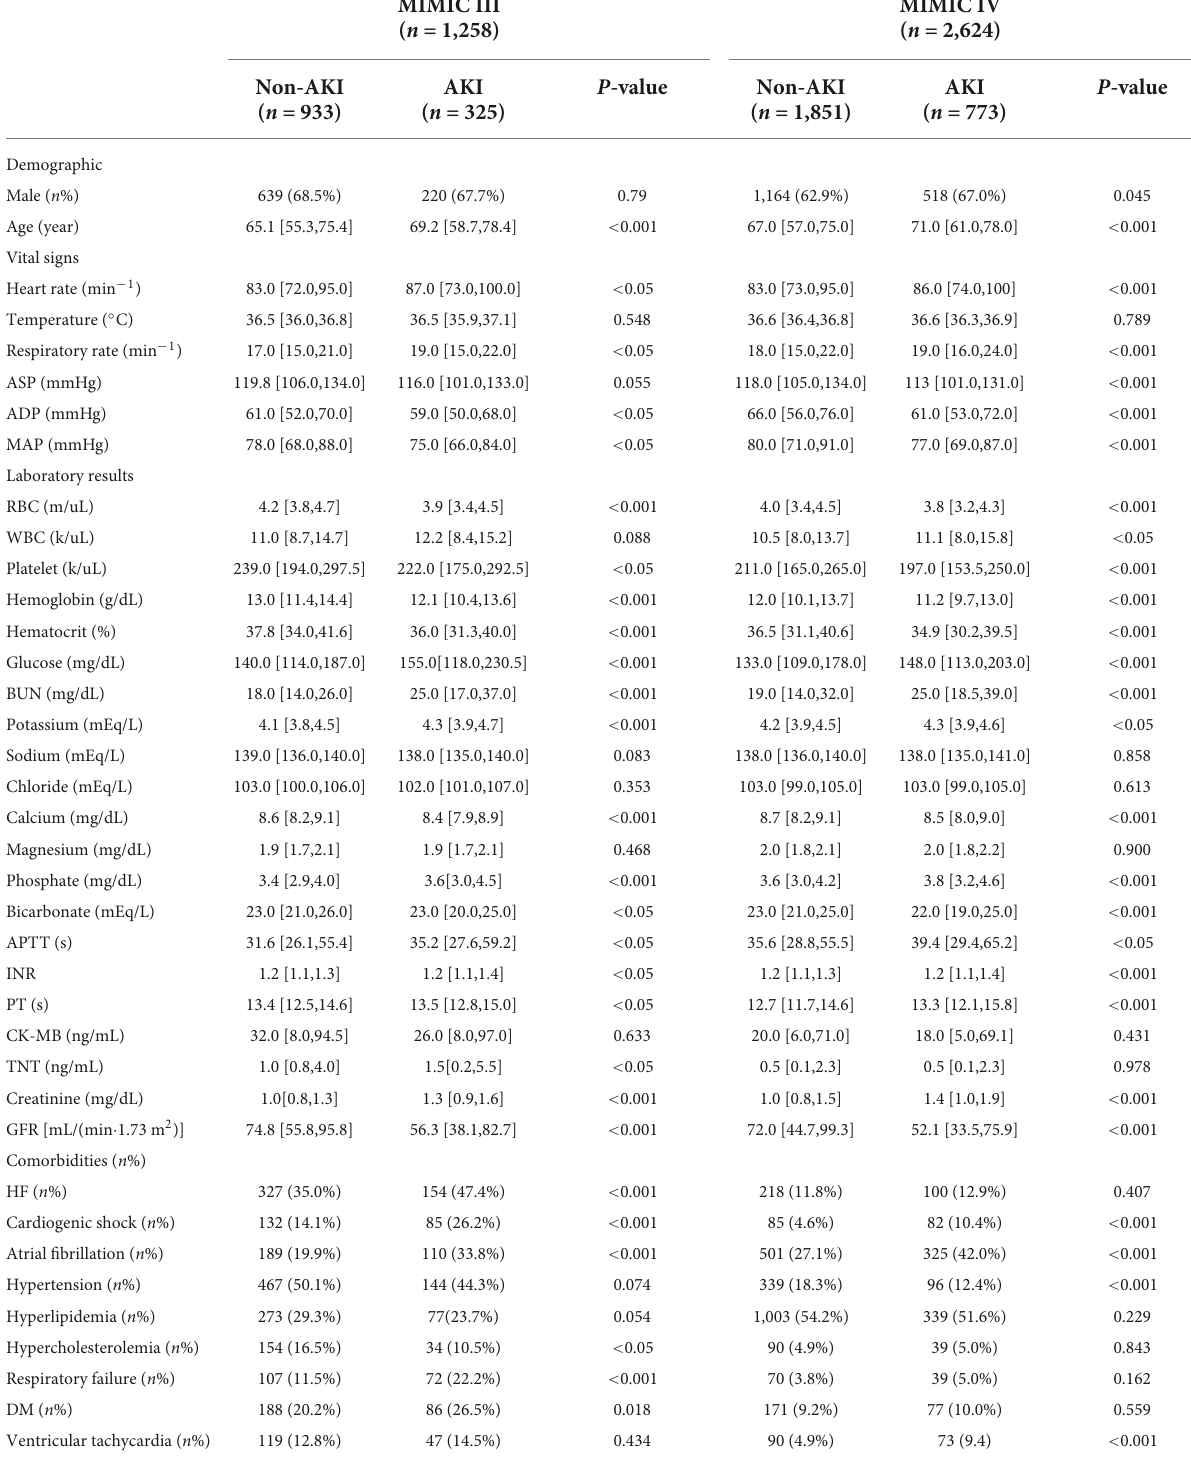
TABLE 1 Baseline